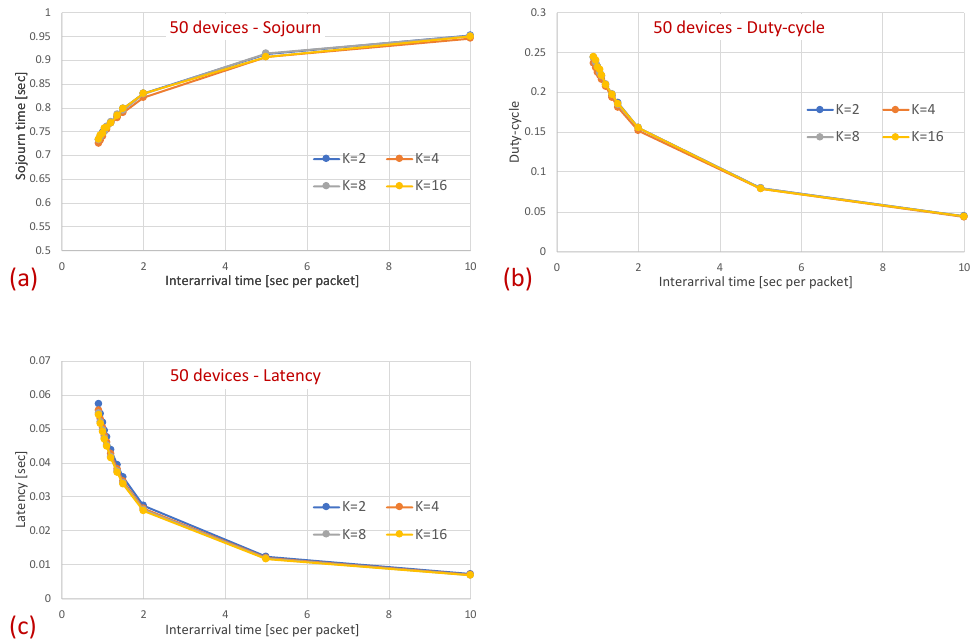
Figure 17. Hidden-terminal topology: The performance of a topology comprising 50 devices under various mean inter-arrival times ( λ ) and K = 2,4,8,16. ( a ) Sojourn time. ( b ) Duty cycle. ( c ) Latency because both the transmitting device and the sink are